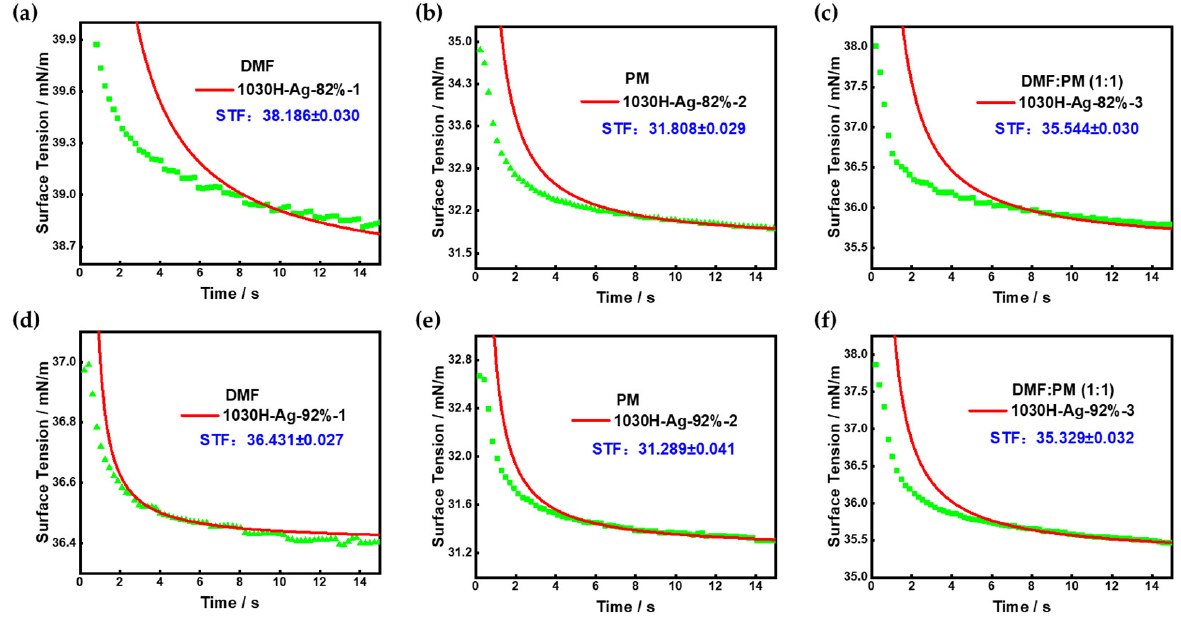
Figure 10. Surface tension of silver conductive ink in different solvent systems. ( a ) 1030H-Ag-82%-1 conductive ink; ( b ) 1030H-Ag-82%-2 conductive ink; ( c ) 1030H-Ag-82%-3 conductive ink; ( d ) 1030H-Ag-92%-1 conductive ink; ( e ) 1030H-Ag-92%-2 conductive ink; ( f ) 1030H-Ag-92%-3 conductive ink.